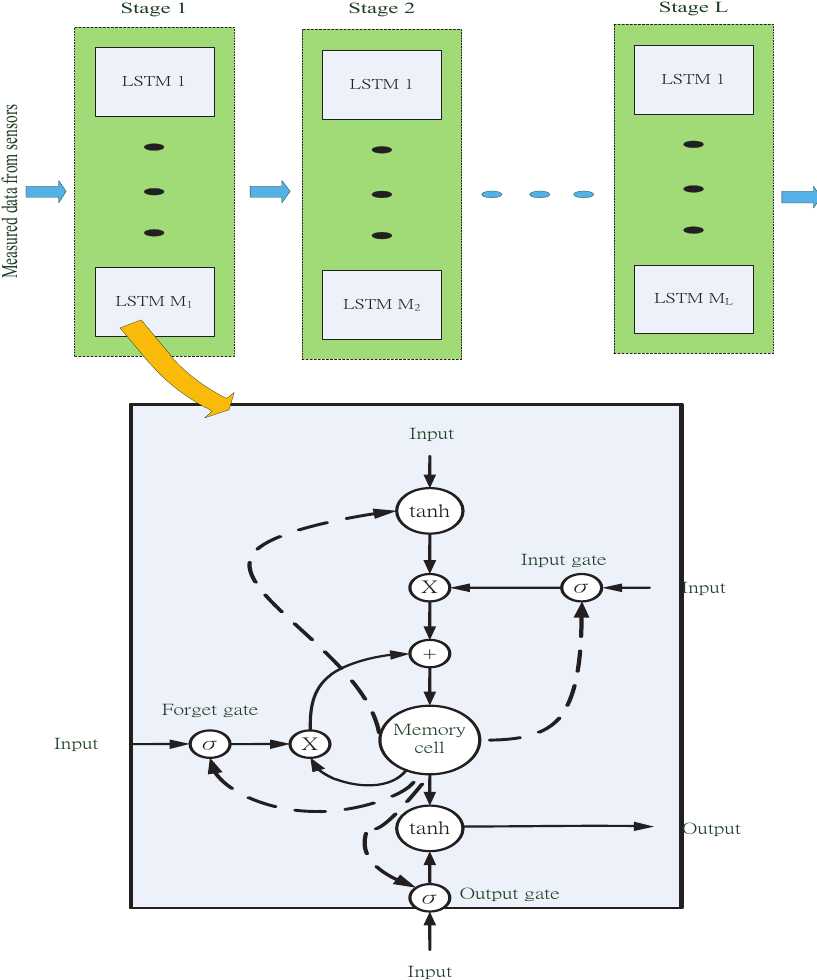
Figure 5. The multilaryer architecture and cell structure of long short-term memory